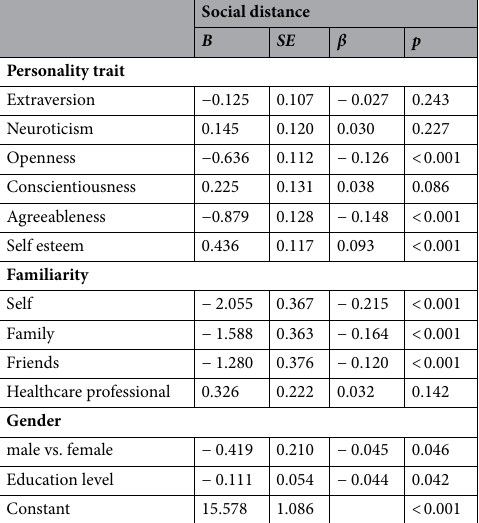
Table 1. Multiple regression analyses for social distance. B, unstandardized regression weight; β, standardized regression weight; SE , standard error; p , p -Value.